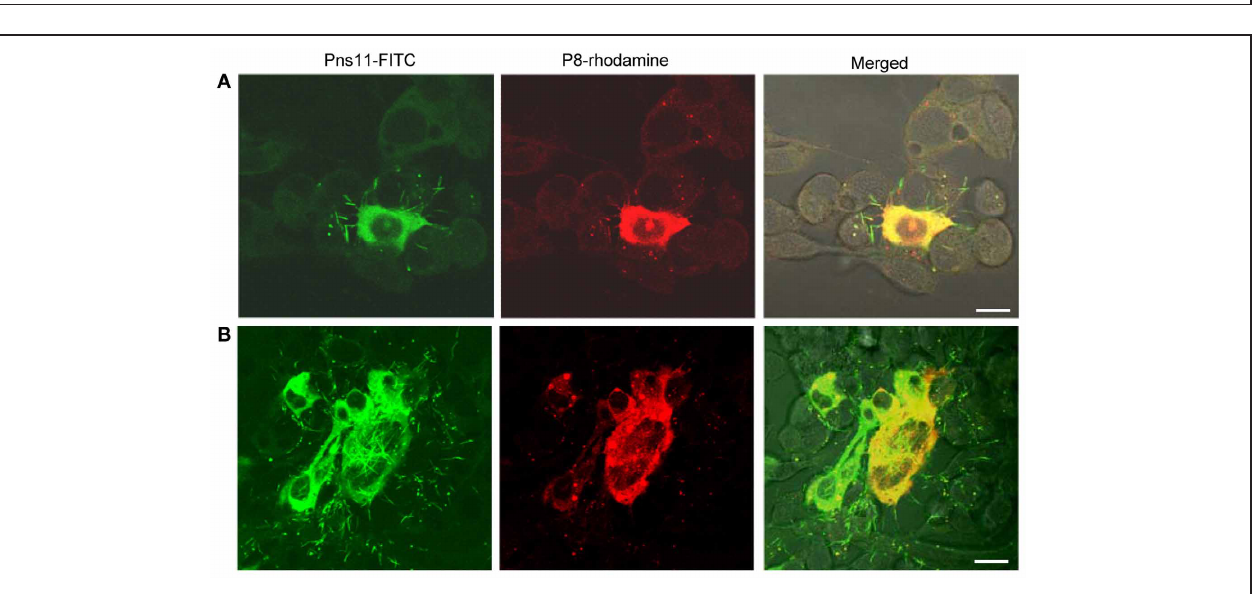
Pns11-specific IgG as primary antibodies, followed by treatment with 10-nm gold particle-conjugated goat antibodies against rabbit IgG as secondary antibodies. Arrows mark gold particles. Bar, 100nm. (C) Immunofluorescence staining of Pns7 showing the diffuse distribution of Pns7 in the cytoplasm of cell. Sf9 cells were immunostained with Pns7-FITC. Bar, 10 µ m.